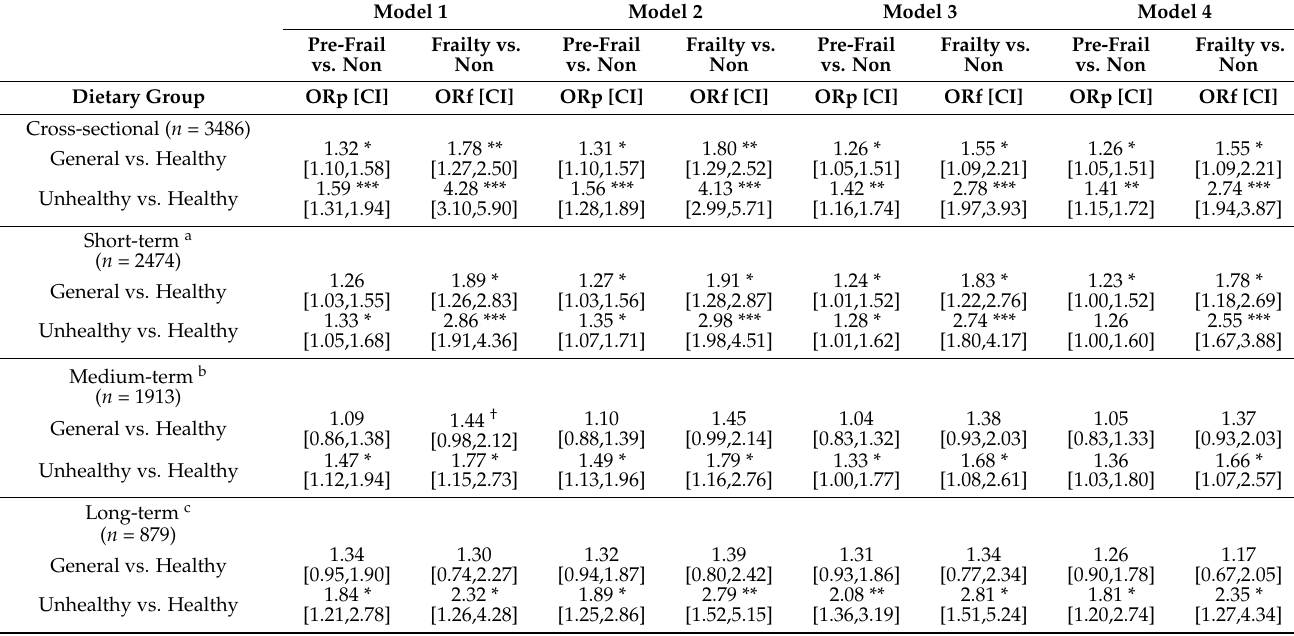
Table 4. Association between dietary patterns and frailty status: cross-sectional (1999), Short-term (2003), medium-term (2007), and long-term (2011)